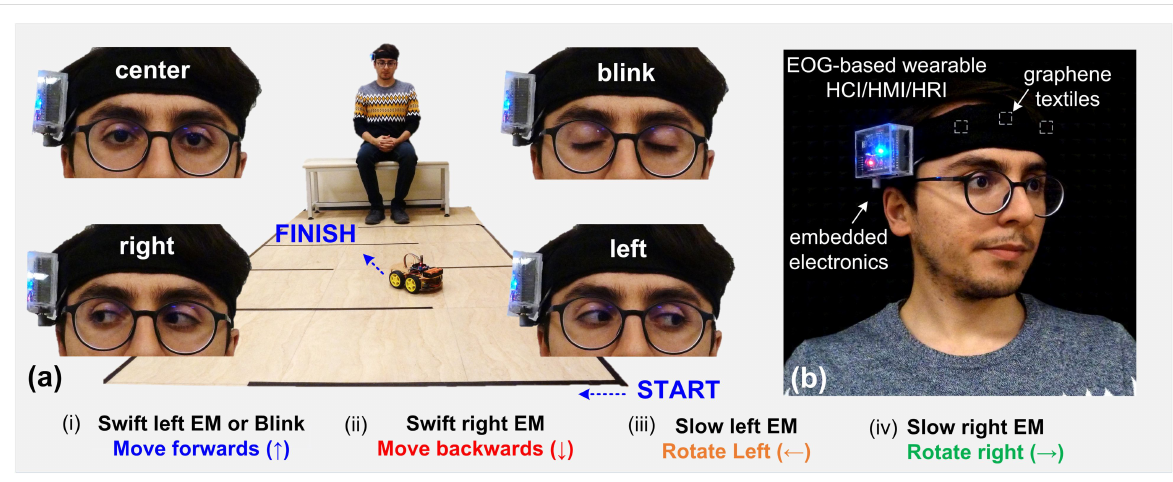
Figure 5: Overview of the second technology demonstrator for the wearable graphene textile-based assistive device for HMI applications. A four- wheeled robot is remotely controlled and steered in a maze. (a) Scenario-specific eye movements (EMs) allow one to steer the robot in different direc- tions as follows: (i) swift left EM or blinking trigger forward motion ( ↑ ), (ii) swift right EM triggers backward motion ( ↓ ), (iii) slow left EM triggers rota- tion to the left ( ← ), (iv) slow right EM triggers rotation to the right ( → ). Insets show images of the eye during different movements. This includes eyes when fixated at the center, while performing a voluntary blink, while performing a right move and fixated at the right, and while performing a left move and fixated at the left; (b) picture of the wearable eye tracker including smart headband with graphene textile electrodes and embedded electronics housed by an acrylic holder all mounted on the head.